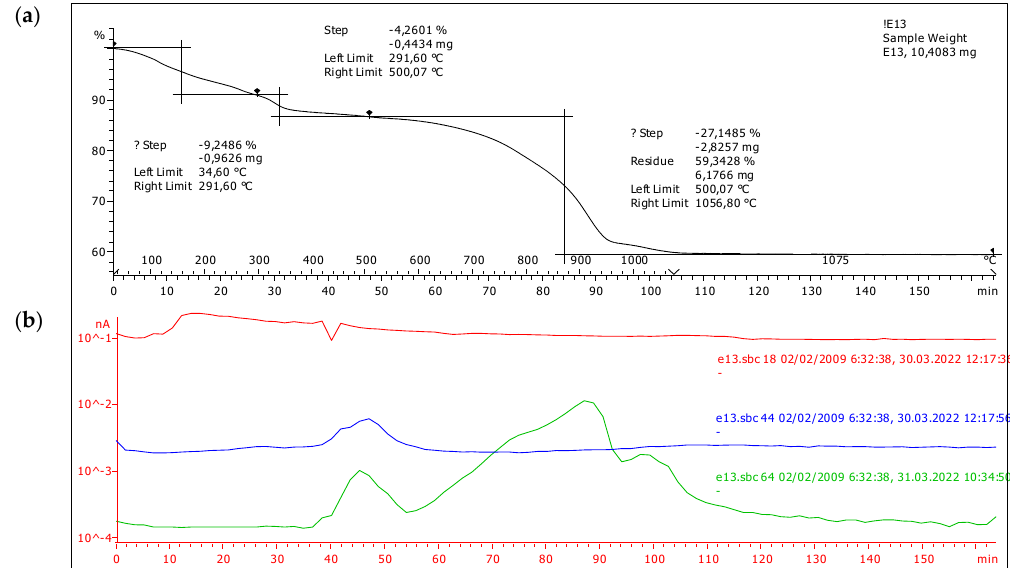
Figure 3 . An example of thermogravimetric analysis (for sample SS13): ( a ) thermogram, ( b ) ionic current plot of gases generated during the sample breakdown, where the red line stands for water profile, the blue line for carbon dioxide and the green line for sulphur trioxide (SO 3 ).